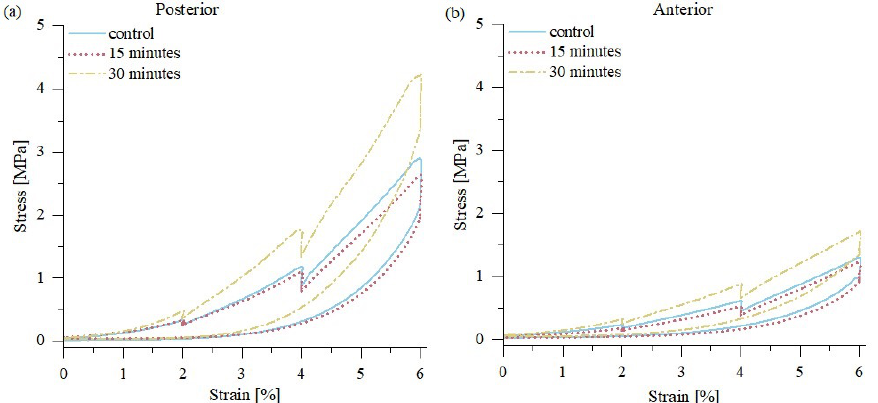
Figure 2. Mean stress-strain curves and standard deviation for the tendon samples taken from ( a ) posterior side and ( b ) anterior side of the tendon; n =